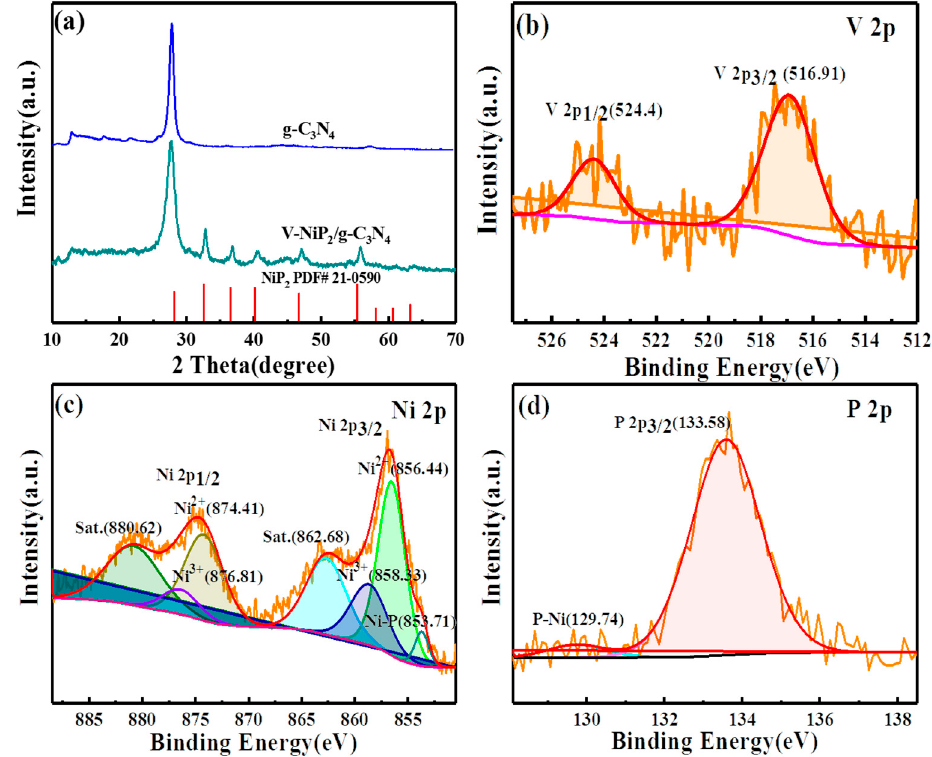
Figure 1. ( a ) XRD patterns of g-C 3 N 4 and V-NiP 2 /g-C 3 N 4 ; The XPS spectra of ( b ) V 2p. ( c ) Ni 2p, and ( d ) P 2p for V-NiP 2 /g-C 3 N 4 .